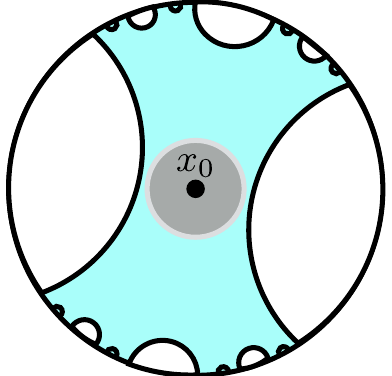
FIG. 5. This figure illustrates uberholography for the case of a two-dimensional hyperbolic bulk geometry. The inner logical boundary is contained inside the entanglement wedge, shaded in blue, of a boundary region R . By repeatedly punching holes of decreasing size out of this boundary region, we obtain a much smaller region R whose entanglement wedge still contains min the logical boundary. Thus, the logical algebra is supported on a fractal boundary set, whose geometry is reminiscent of the Cantor